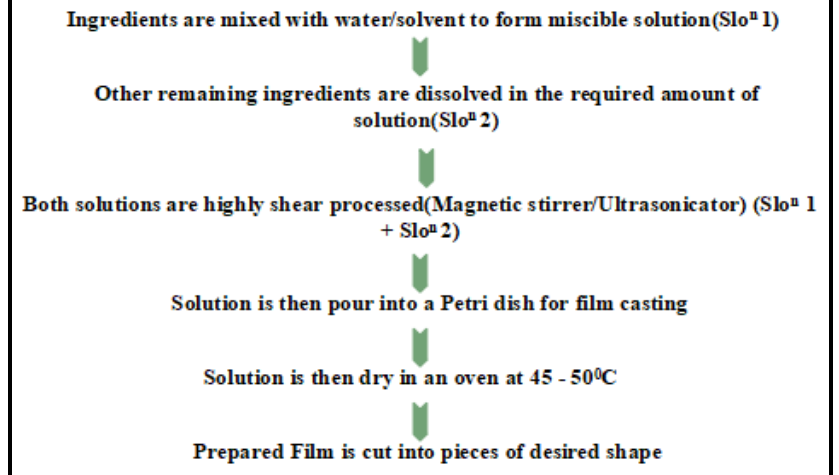
Figure 1. Solution casting technique.